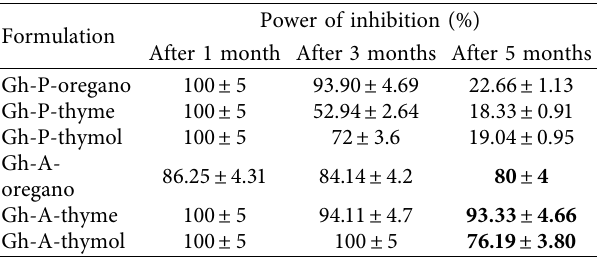
Table 3: The antifungal activity of the prepared formulations of thymol, thyme, and